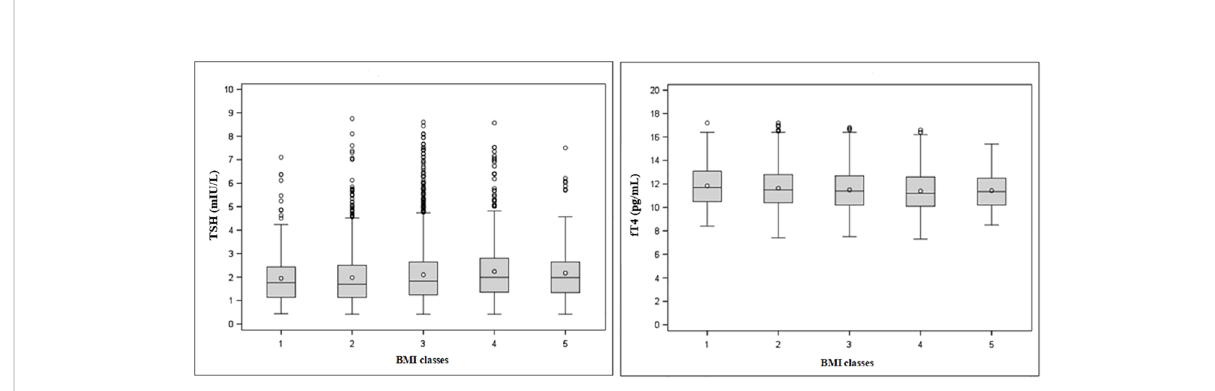
FIGURE 3 Tukey ’ s box-and-whisker plot of TSH (left) and fT4 levels (right) according to BMI classes. Outliers are plotted as individual